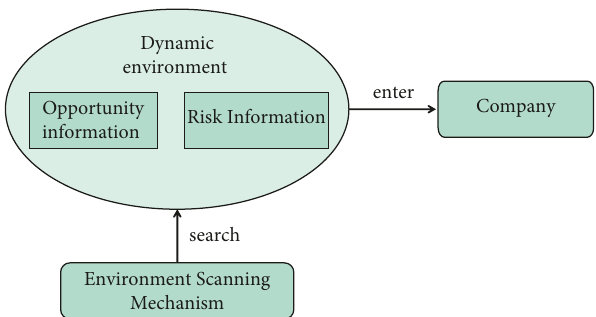
Figure 6: Functional diagram of environmental scanning mechanism.